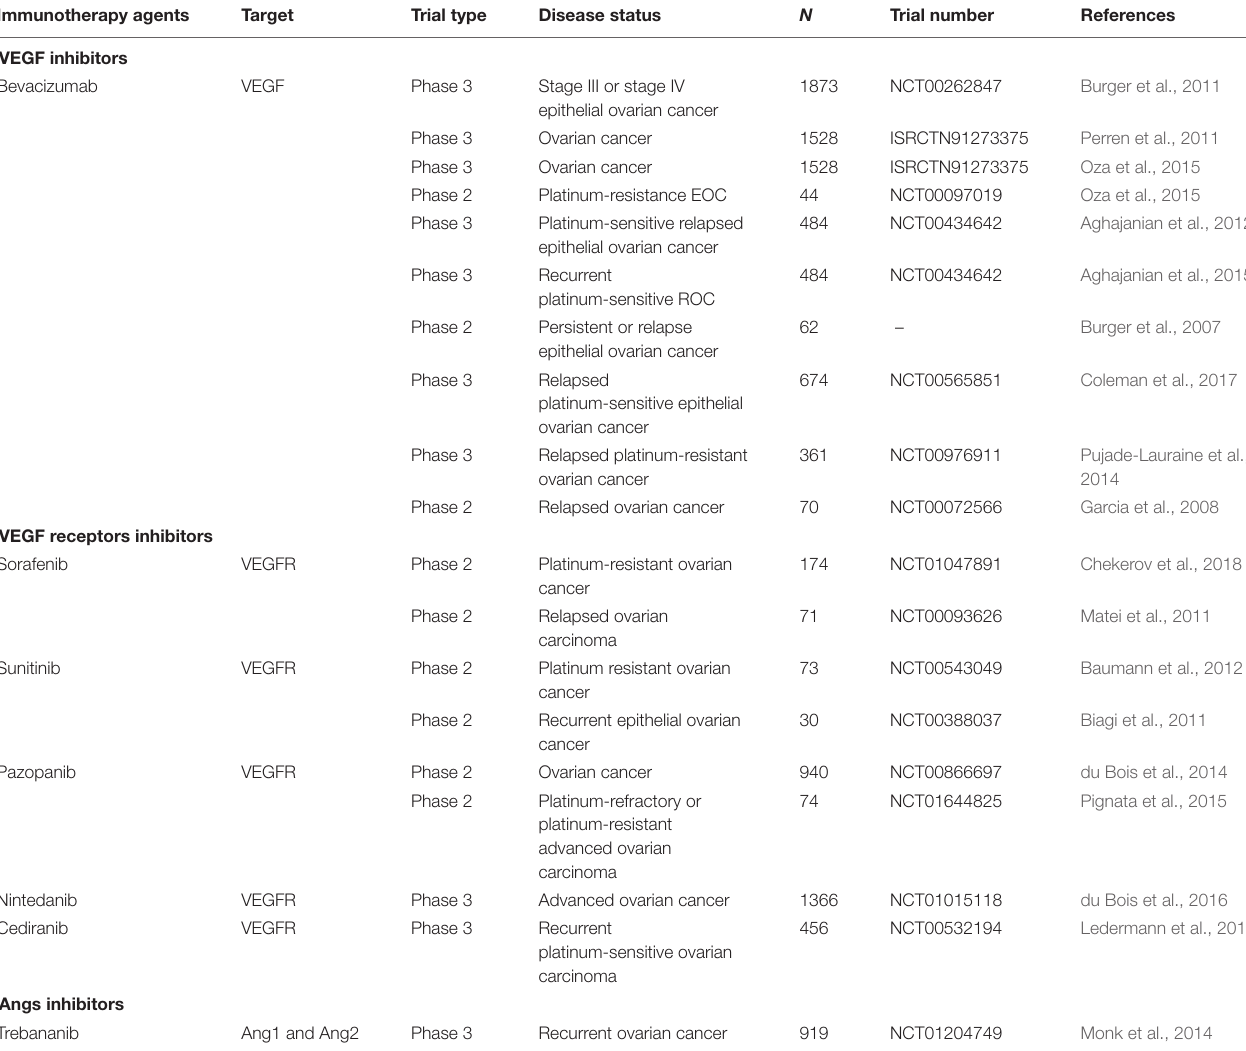
TABLE 1 | Clinical trials of therapies that target angiogenesis in ovarian